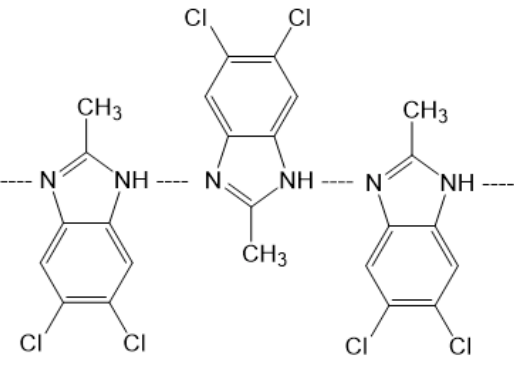
Figure 1. Hydrogen-bonded molecular chain of 5,6-dichloro-2-methylbenzimidazole (DC-MBI).